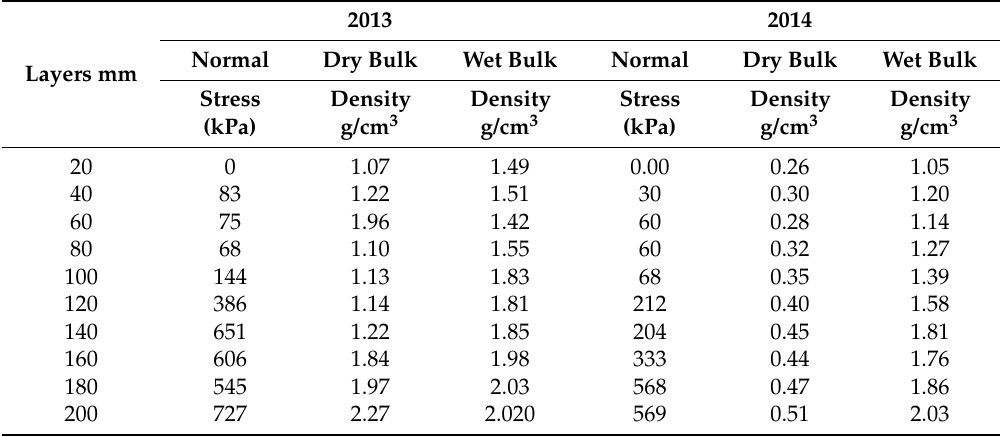
Table 1. Main soil strength parameters and average value of soil bulk density on each 20-mm layer. Layers